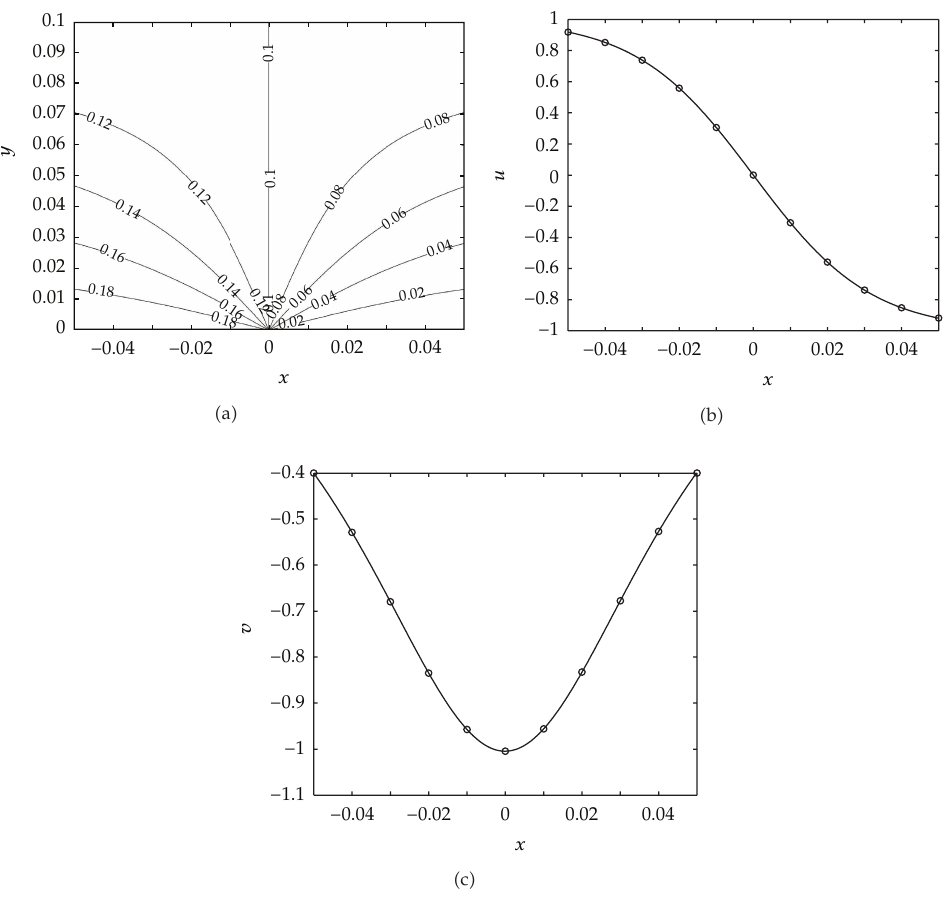
Figure 6: (cid:5) a (cid:6) Analytical streamlines of the two-dimensional flow for the horizontal Euler/Laplace local case shown in Figure 4 (cid:5) a (cid:6) . The streamlines are directed towards the origin. Also plotted are the (cid:5) b (cid:6) horizontal and (cid:5) c (cid:6) vertical velocities along the horizontal centreline for both the computational (cid:5) small circles (cid:6) and analytical (cid:5) line (cid:6)